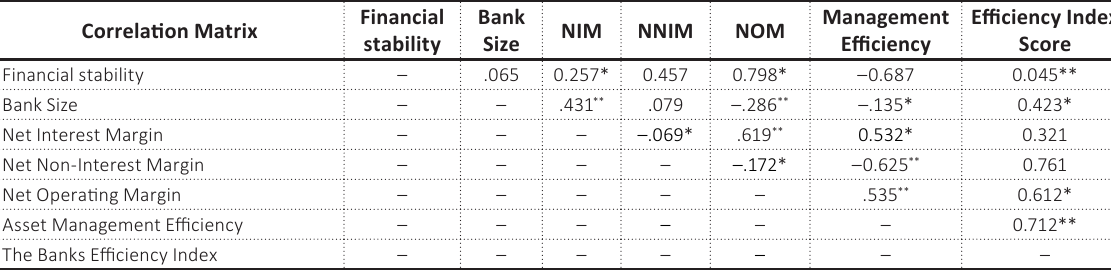
Table 13. Correlations matrix for Model D